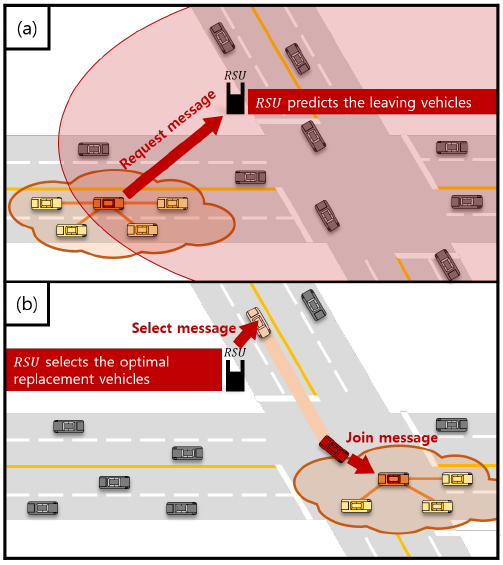
Figure 1. The network model and scheme overview: ( a ) when a vehicular cloud enters into the communication coverage of a RSU, the requester vehicle sends a request message to the RSU to carry out the member vehicle replacement, and ( b ) the RSU selects the optimal replacement vehicles, and the vehicular cloud is reconstructed with the optimal replacement